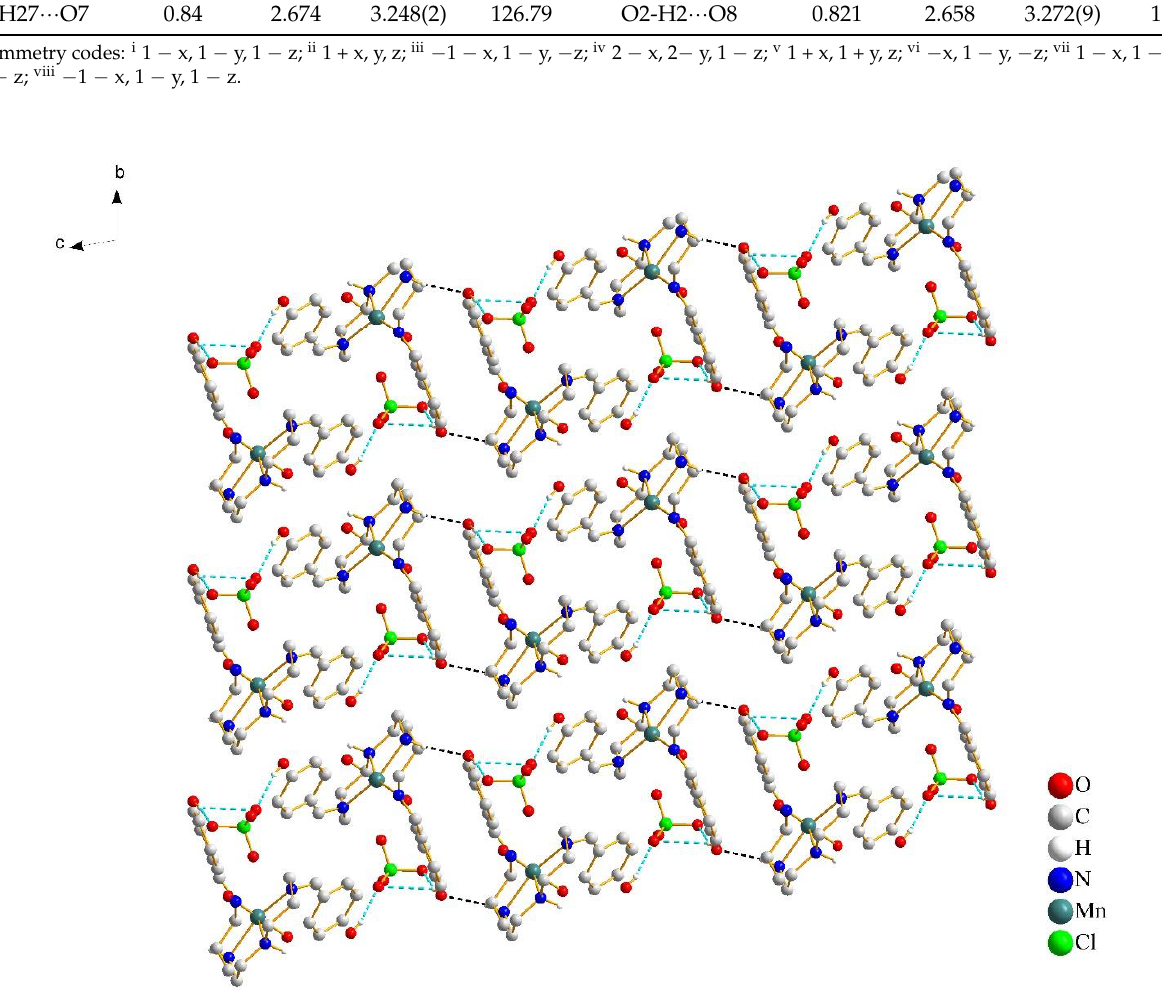
Figure 5. Crystal packing of complex 2 at 100 K, viewed along the a -axis. The cation – anion O – H···O hydrogen bonds are shown with cyan blue dash lines and the cation – cation N – H···O hydrogen bonds are shown with black lines. Most of the hydrogen atoms were omitted for clarity, except for those involved in hydrogen bonds.